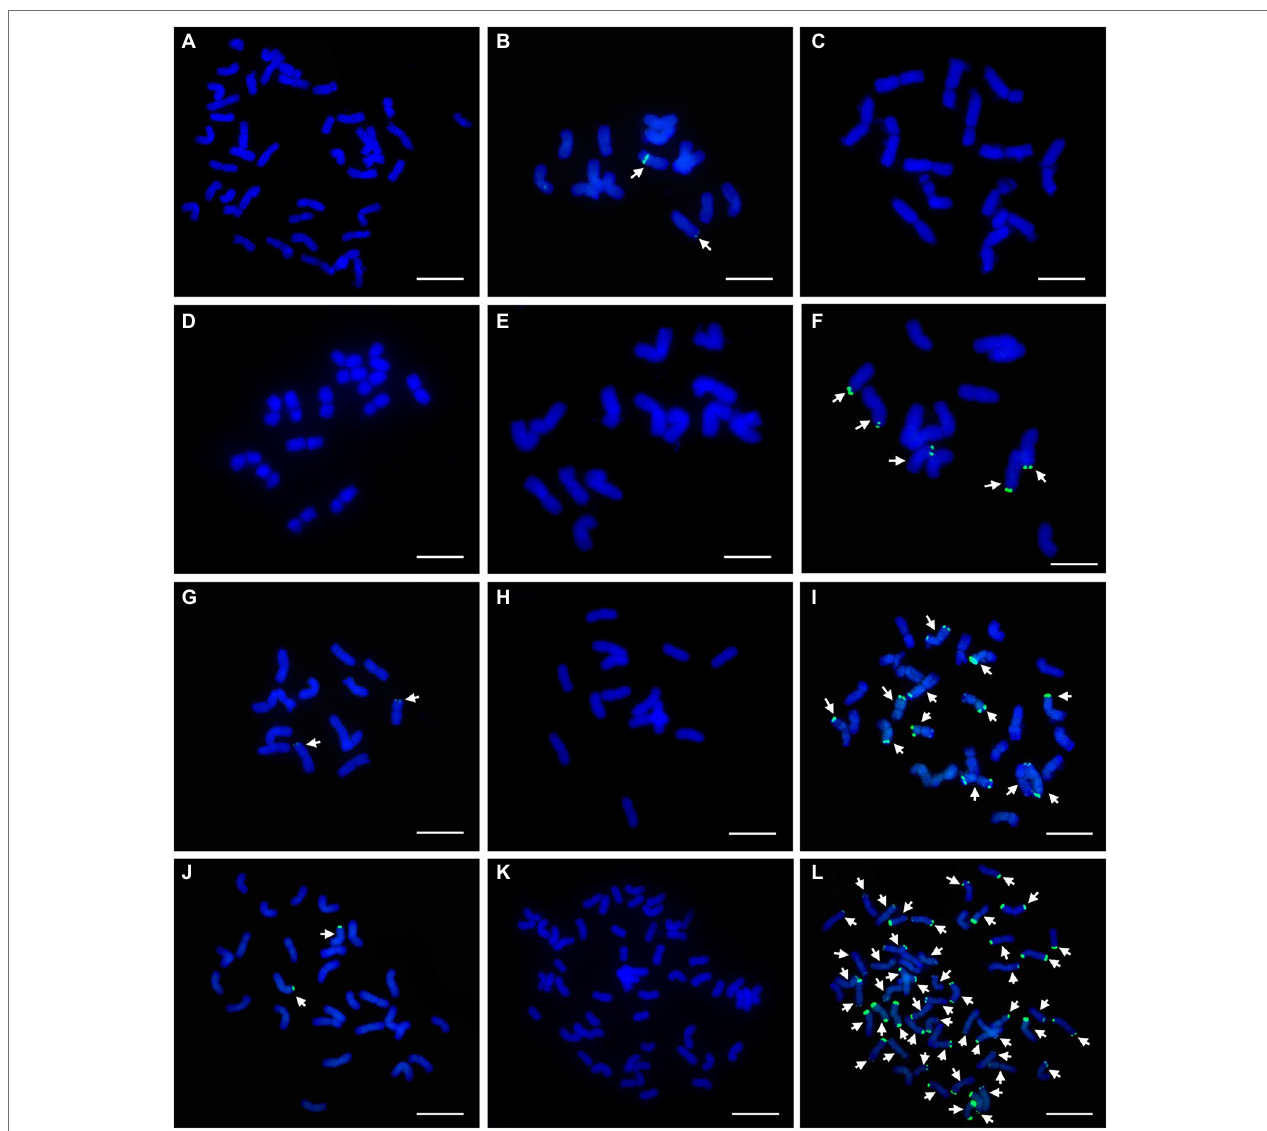
FIGURE 9 | FISH patterns of repetitive DNA probe pPh37 (green) in CS and 11 wheat-related species. (A) CS; (B) P. juncea ; (C) S. cereal ; (D) H. vulgre ; (E) Ag. cristatum ; (F) Das. villosum ; (G) Pse. libanotica ; (H) Th. elongatum ; (I) L. racemosus ; (J) L. multicaulis ; (K) L. arenarius ; and (L) L. cinereus . Arrows indicate partial chromosomes with strong hybridization signals. Scale bar: 10 μ